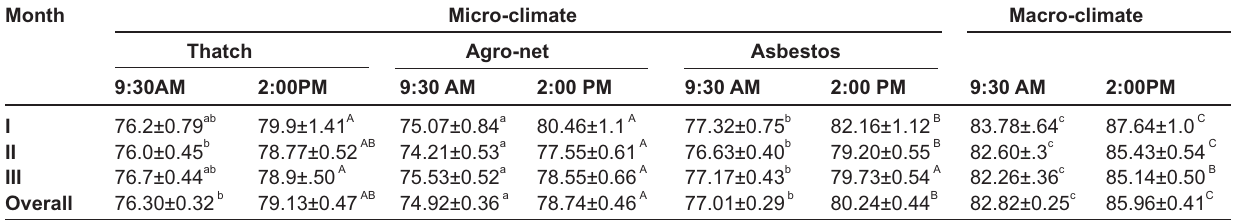
Table-2. THI values of micro-climate (under different shade materials) and macro-climate during rainy season Month